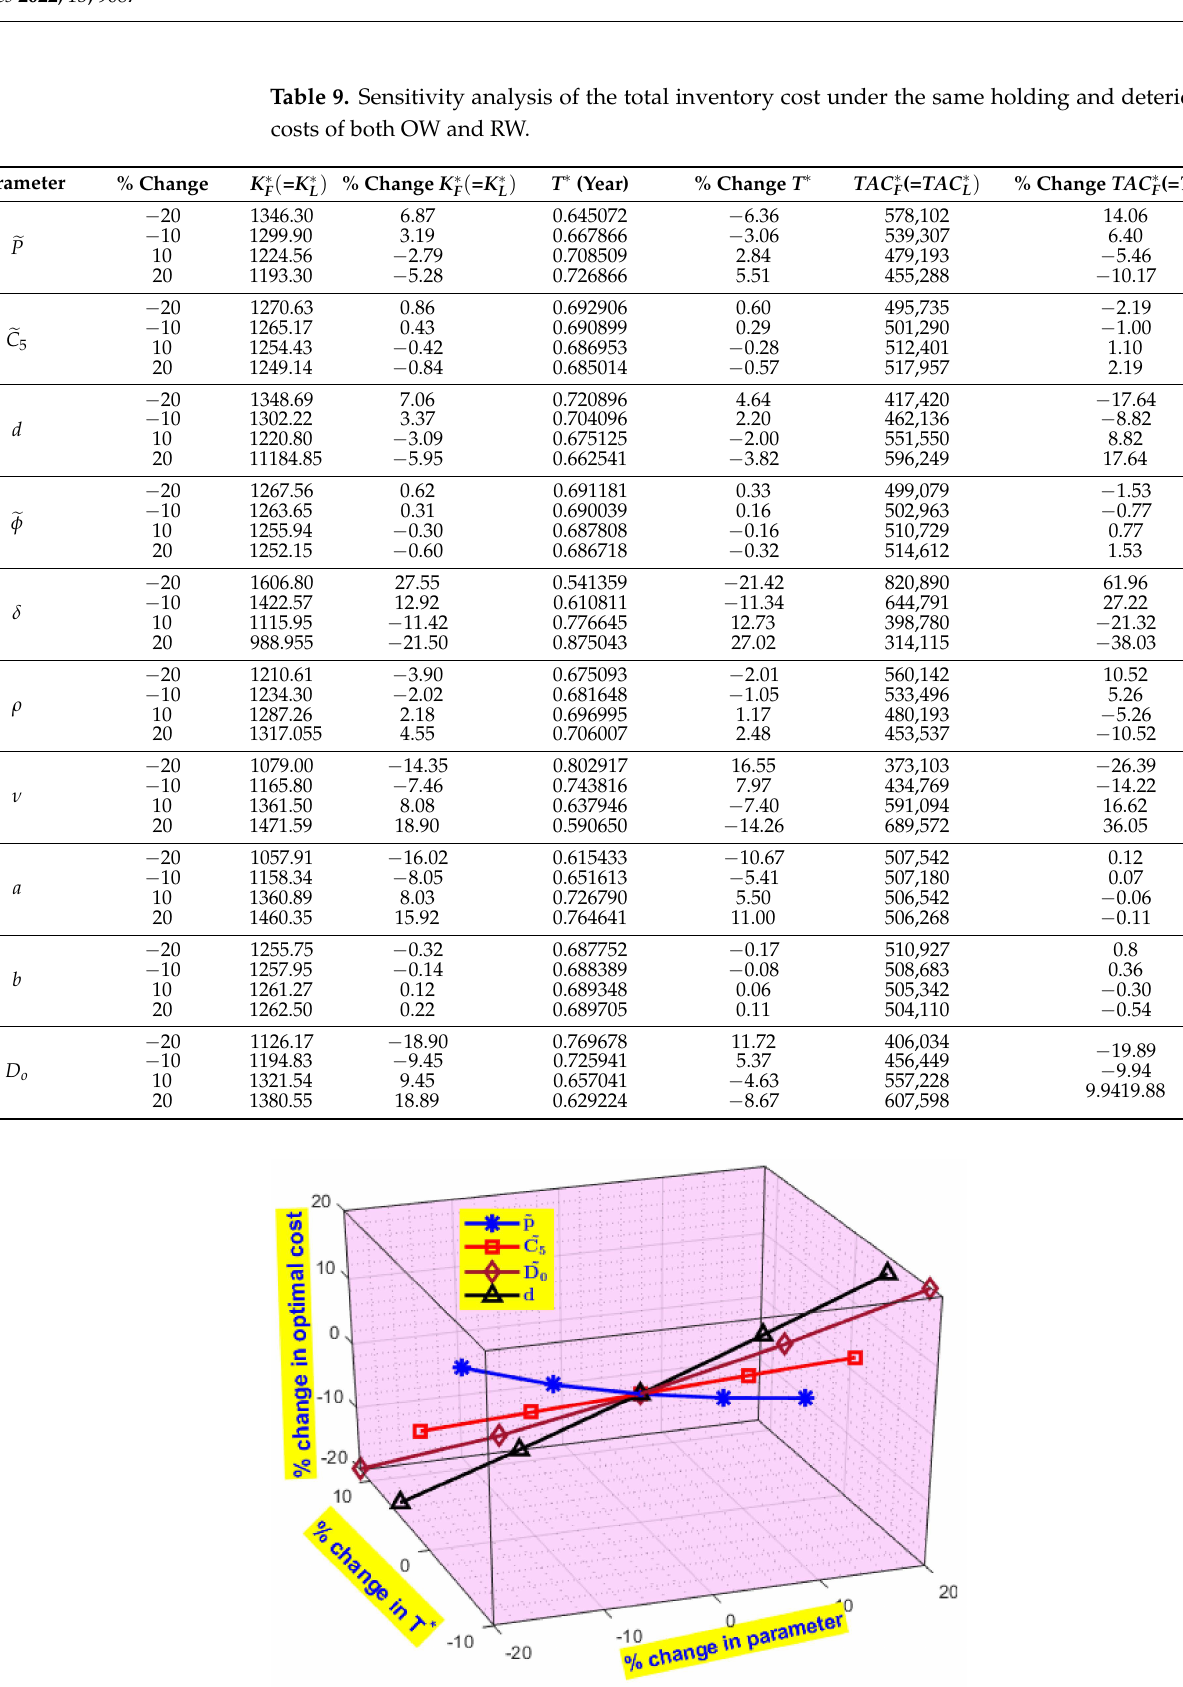
Figure 9. Changes in optimal cost by variations of inventory